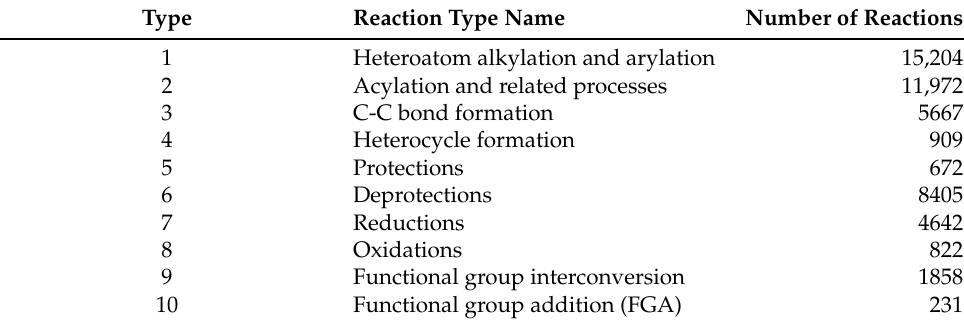
Table A1. Distribution of 10 recognized reaction types.